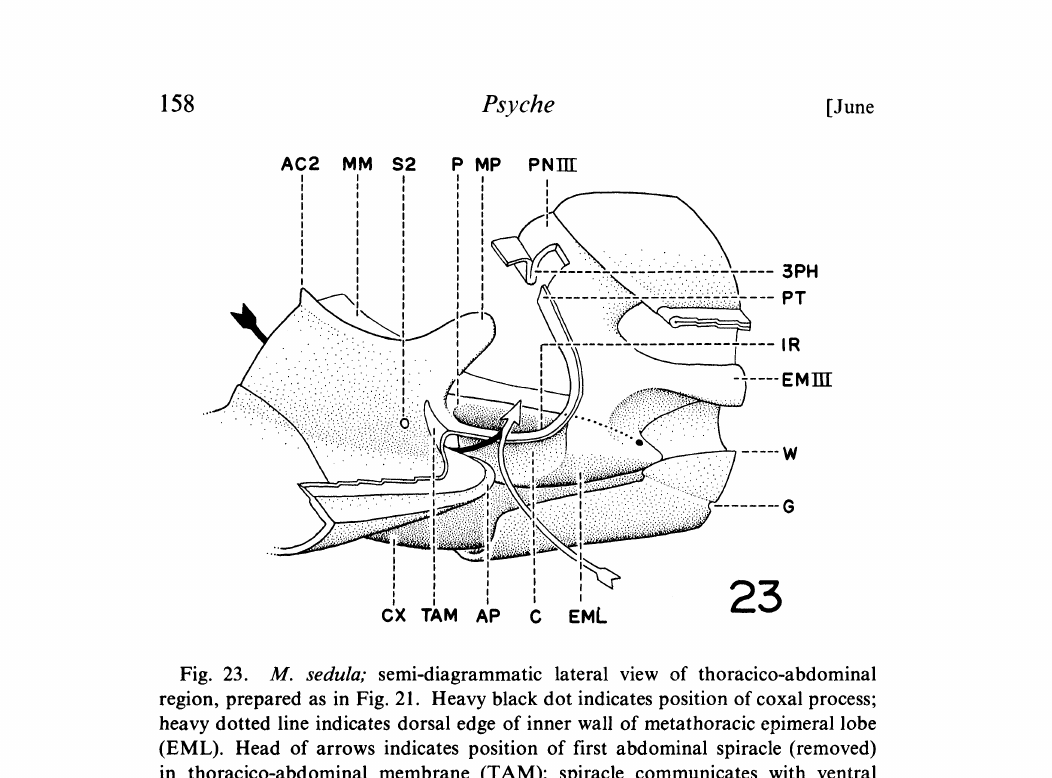
Fig. 23. M. sedula; semi-diagrammatic lateral view of thoracico-abdominal region, prepared as in Fig. 21. Heavy black dot indicates position of coxal process; heavy dotted line indicates dorsal edge of inner wall of metathoracic epimeral lobe (EML). Head of arrows indicates position of first abdominal spiracle (removed) in thoracico-abdominal membrane (TAM); spiracle communicates with ventral air store (white arrow) and with air store surounding metacoxa (black